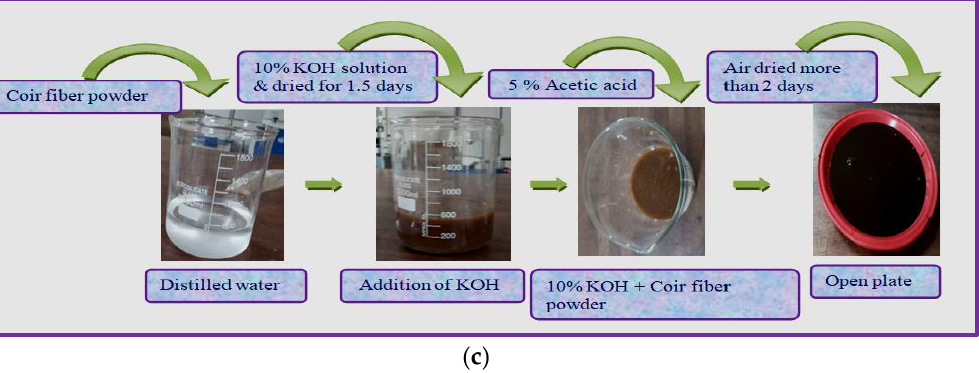
Figure 3. ( a ) Triethoxy(ethyl) silane treatment [50]. ( b ) Sodium hydroxide (NaOH) treatment [51]. ( c ) Potassium hydroxide (KOH) treatment [52].